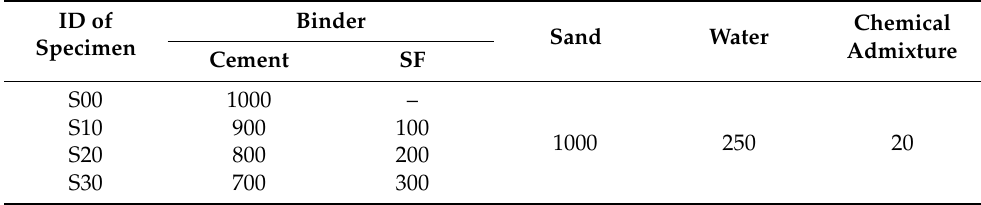
Table 2. Mixture proportions of the specimens (Unit: